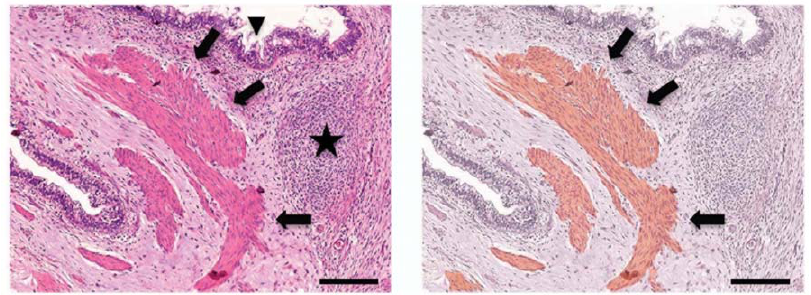
Figure 3. hMPs form muscle invivo . Teratomas formed from a MHC-GFP hESCs by renal capsule grafting in SCID mice were analyzed by hematoxylin and eosin staining to identify tissue structures ( left ), and immunohistochemistry with anti-GFP antibody ( right ) to identify tissues arising from hMPs. Section from typical teratoma shown (n=7). Primitive neural epithelium (star) and glandular intestinal structures (arrowheads) can be seen surrounding striated muscle (arrows) ( left ), which stains positive for GFP expression (brown; right ). GFP was expressed exclusively in mononucleated myofibers within the teratomas, and was not found in any other tissues (not shown). Bar, 100 m m.